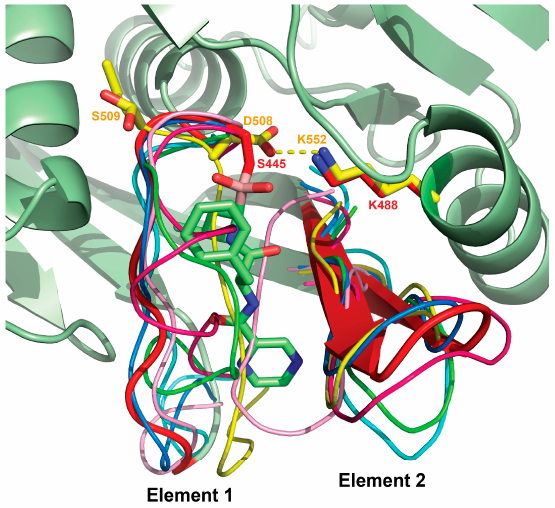
Figure 8. Transition from the active to the inactive state of the P domain. This transition is assisted by the movement and conformational changes in two mobile elements (1 and 2) in the active site. These superimposed fragments are shown in Bs LonBA (red); LonAs: Ec LonA (1rre and 6u5z, pink and green, respectively) and h MtLonA (7krz, cyan); LonBs: Mj LonB (1xhk, magenta), Ton LonB (3kij, blue), and Af LonB (1z0w, yellow). The inhibitor, bortezomib, bound to Bs LonBA is shown in sticks, the P domain of Bs LonBA is shown in a cartoon representation in pale green.